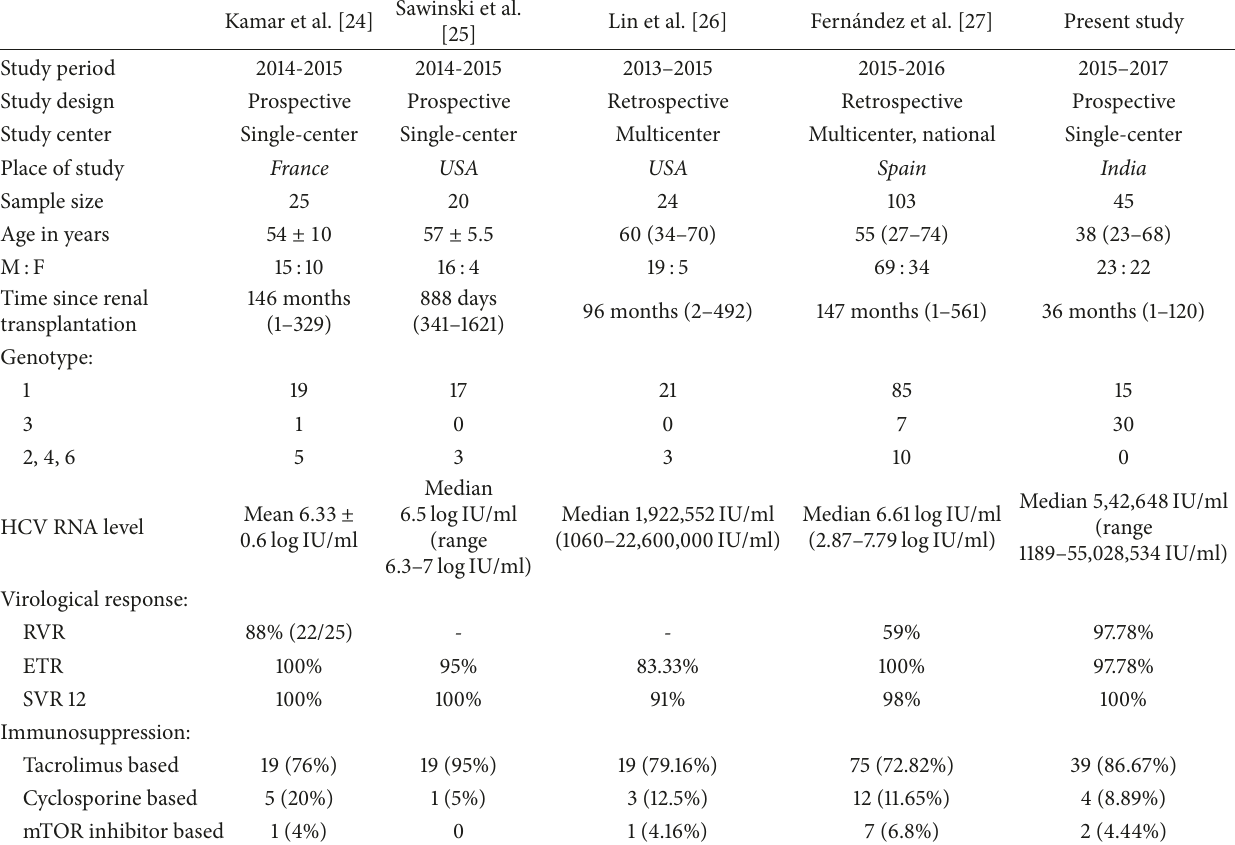
Table 6: Comparison of study pattern, demographics, virological profile, and response to therapy with other published studies. Sawinski et al. Kamar et al. [24] Lin et al. [26] Fern´andez et al. [25]